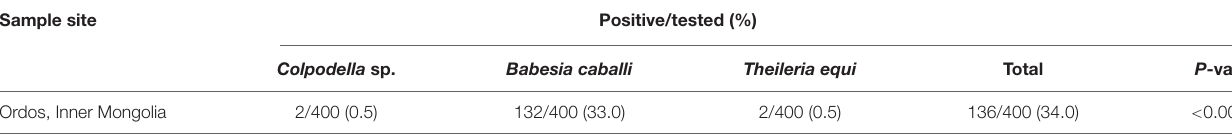
TABLE 1 | Infection of three protozoa among horses collected in Inner Mongolia.